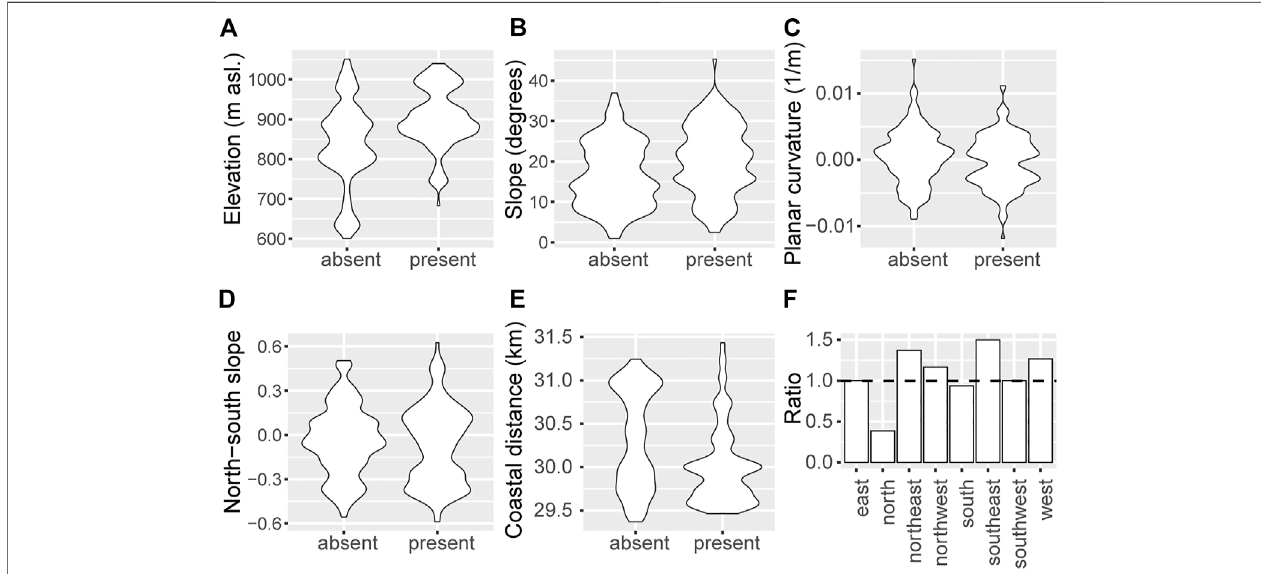
FIGURE5| Distributionofpresentandabsentobservationsaccordingto (A) elevation (B) slope (C) planarcurvature (D) northsouthslopeand (E) coastaldistance (F) Factorial aspect as ratio of present over absent observations within each of the eight cardinal directions. Values above one indicate that there are more present observations than expected at random.